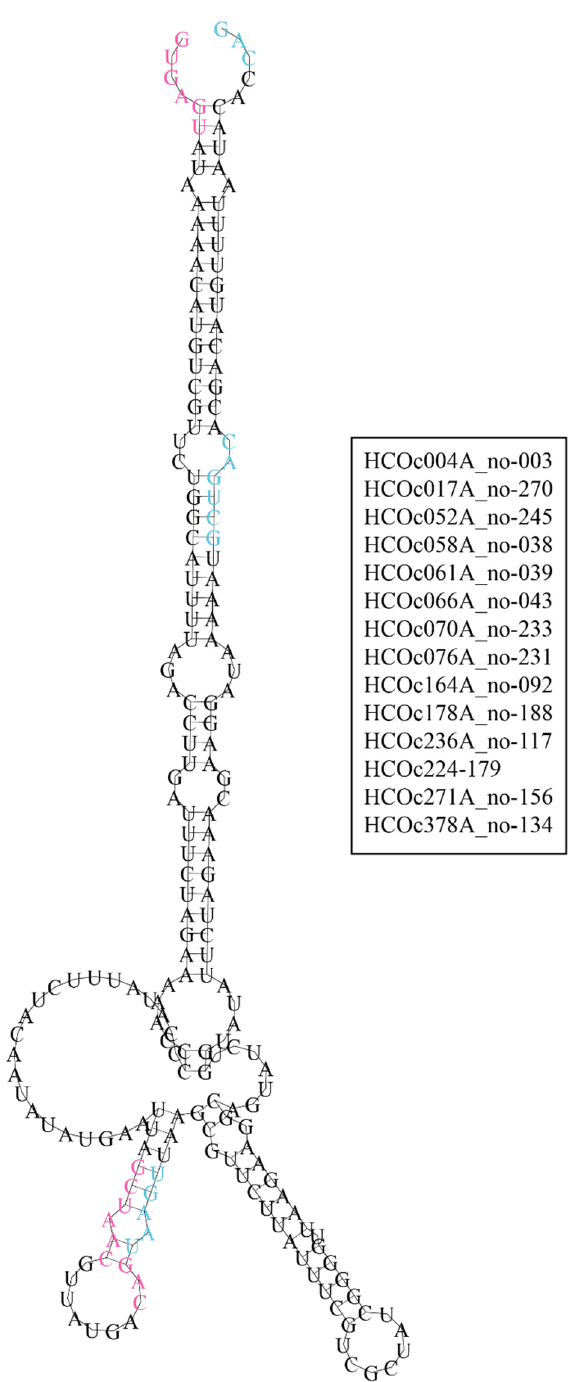
Figure 7. Optimal secondary structure prediction of a consensus sister stwintron deduced from a multiple sequence alignment. The RNAalifold program predicts the folding of a consensus RNA sequence derived from a Multiple Sequence Alignment of a set of sequence-similar RNAs. The basis of the Figure is the MAFFT alignment of the 23 Hypoxylon sp. CO27-5 sister stwintrons shown in our previous publication (cf., [25], Figure 2 therein). Two of the most sequence divergent stwintrons (i.e., HCOc002A and HCOc552A) were omitted. Positions where nts were present in only one or two